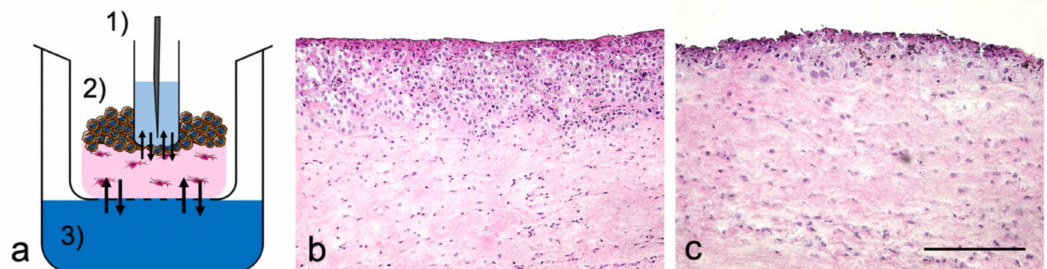
Figure 1. Experimental design and morphology of tumor oral mucosa (TOM) models. ( a ) Schematic cross-section of (1) sampling port with the needle of the autosampler, (2) TOM model with tumor cells (brown) and fibroblasts (magenta) within lamina propria, (3) Reservoir with di ff erentiation medium, supplemented with docetaxel. The arrows indicate drug di ff usion equilibria. Hematoxylin and eosin (H&E) staining of TOM models following two applications of ( b ) the vehicle control and ( c ) 7000 ng / mL docetaxel. Images were representative of four batches; scale bar = 250 µ